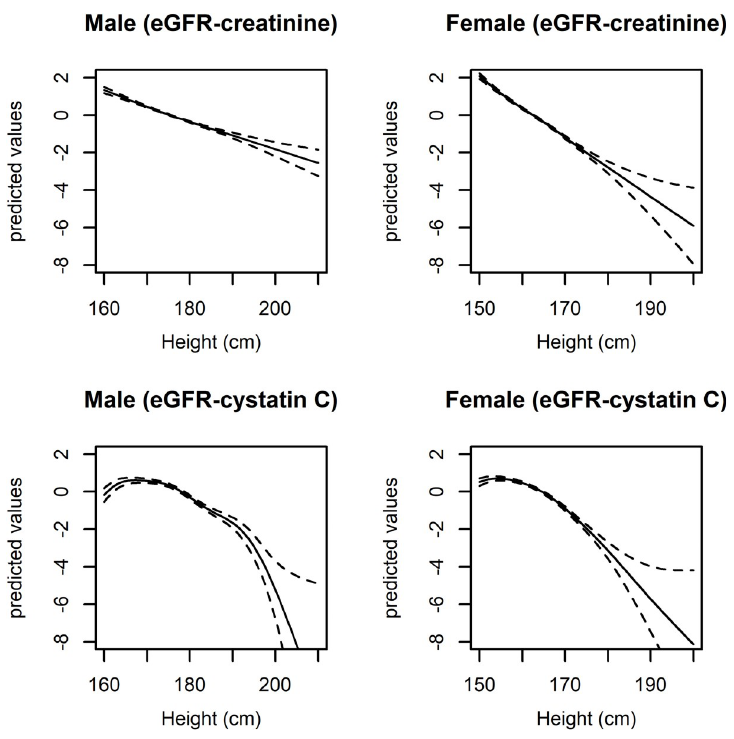
Fig 2. Generalized additive model demonstrating the association between eGFR and height adjusted for age and body mass index for each sex. The x-axes indicate the measured baseline height (cm), and the y-axes indicate zero- centered predictive values for eGFR based on generalized additive models. The broken lines indicate 95% confidence intervals. eGFR = estimated glomerular filtration rate.